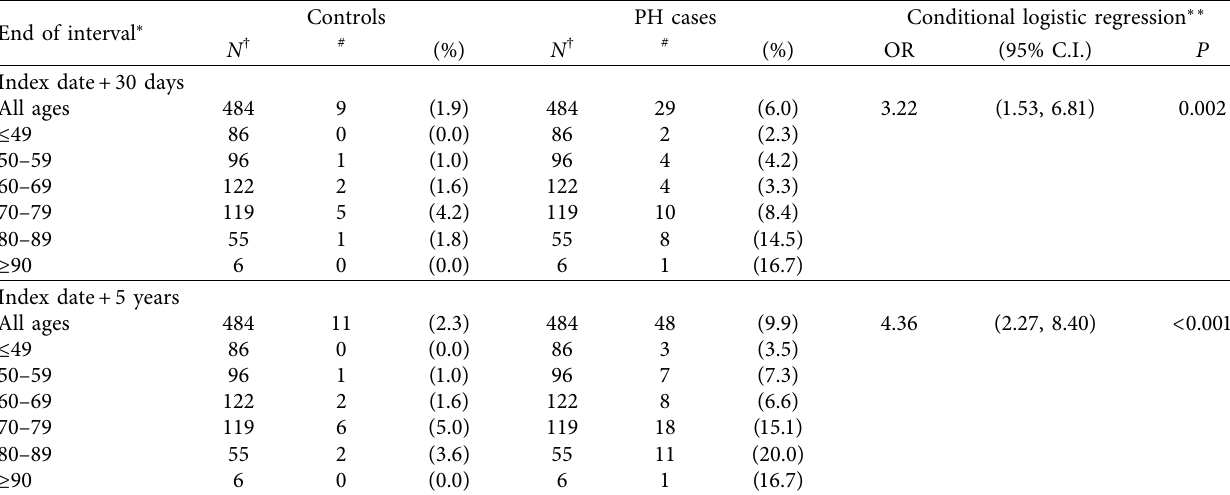
Table 2: Frequency of MGUS diagnosis among 484 PH cases with right heart catheterization and their matched controls. End of interval